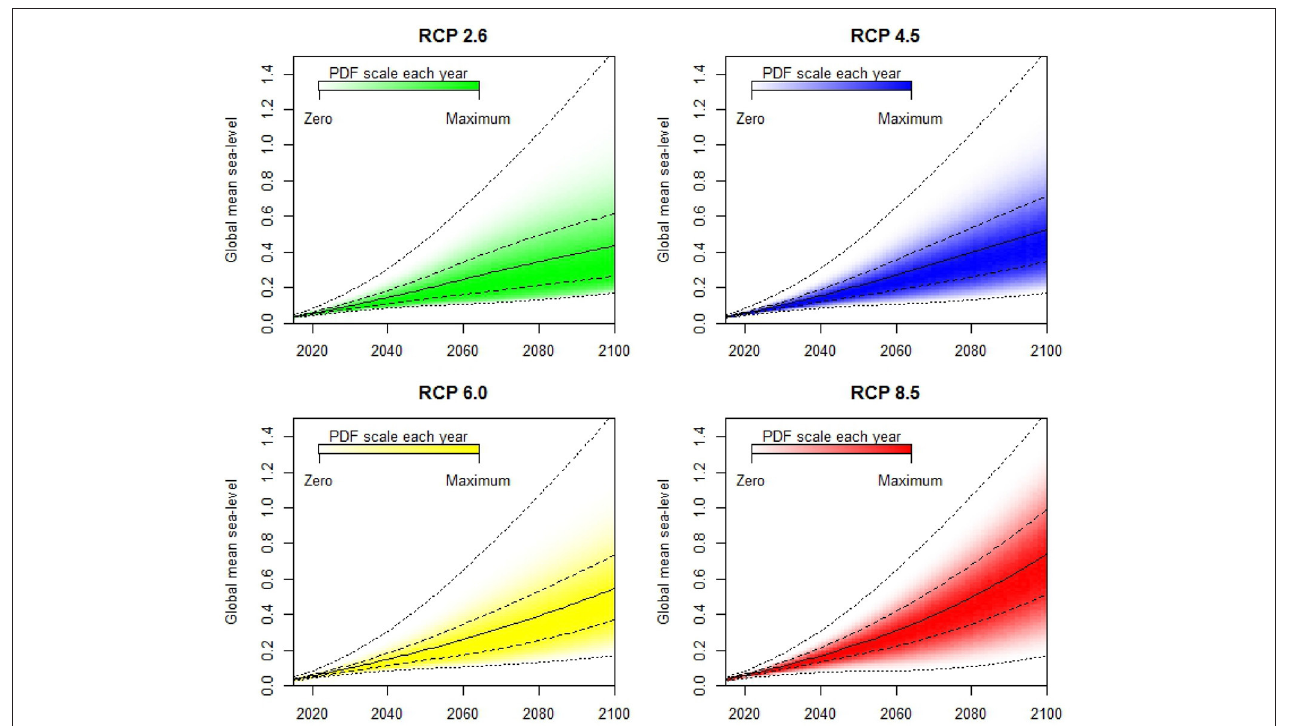
FIGURE 1 | Probabilistic global sea-level rise projections used in this study. For each date, the intensity of the color represents the probability density function (PDF), and the solid and dashed black lines represent the median and likely ranges. The dotted lines represent the minimum and maximum values.